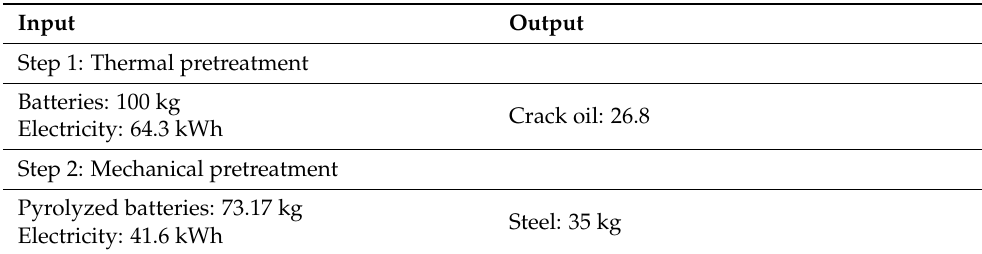
Table A1. Mass and energy balances for the innovative pyro-metallurgical process developed by